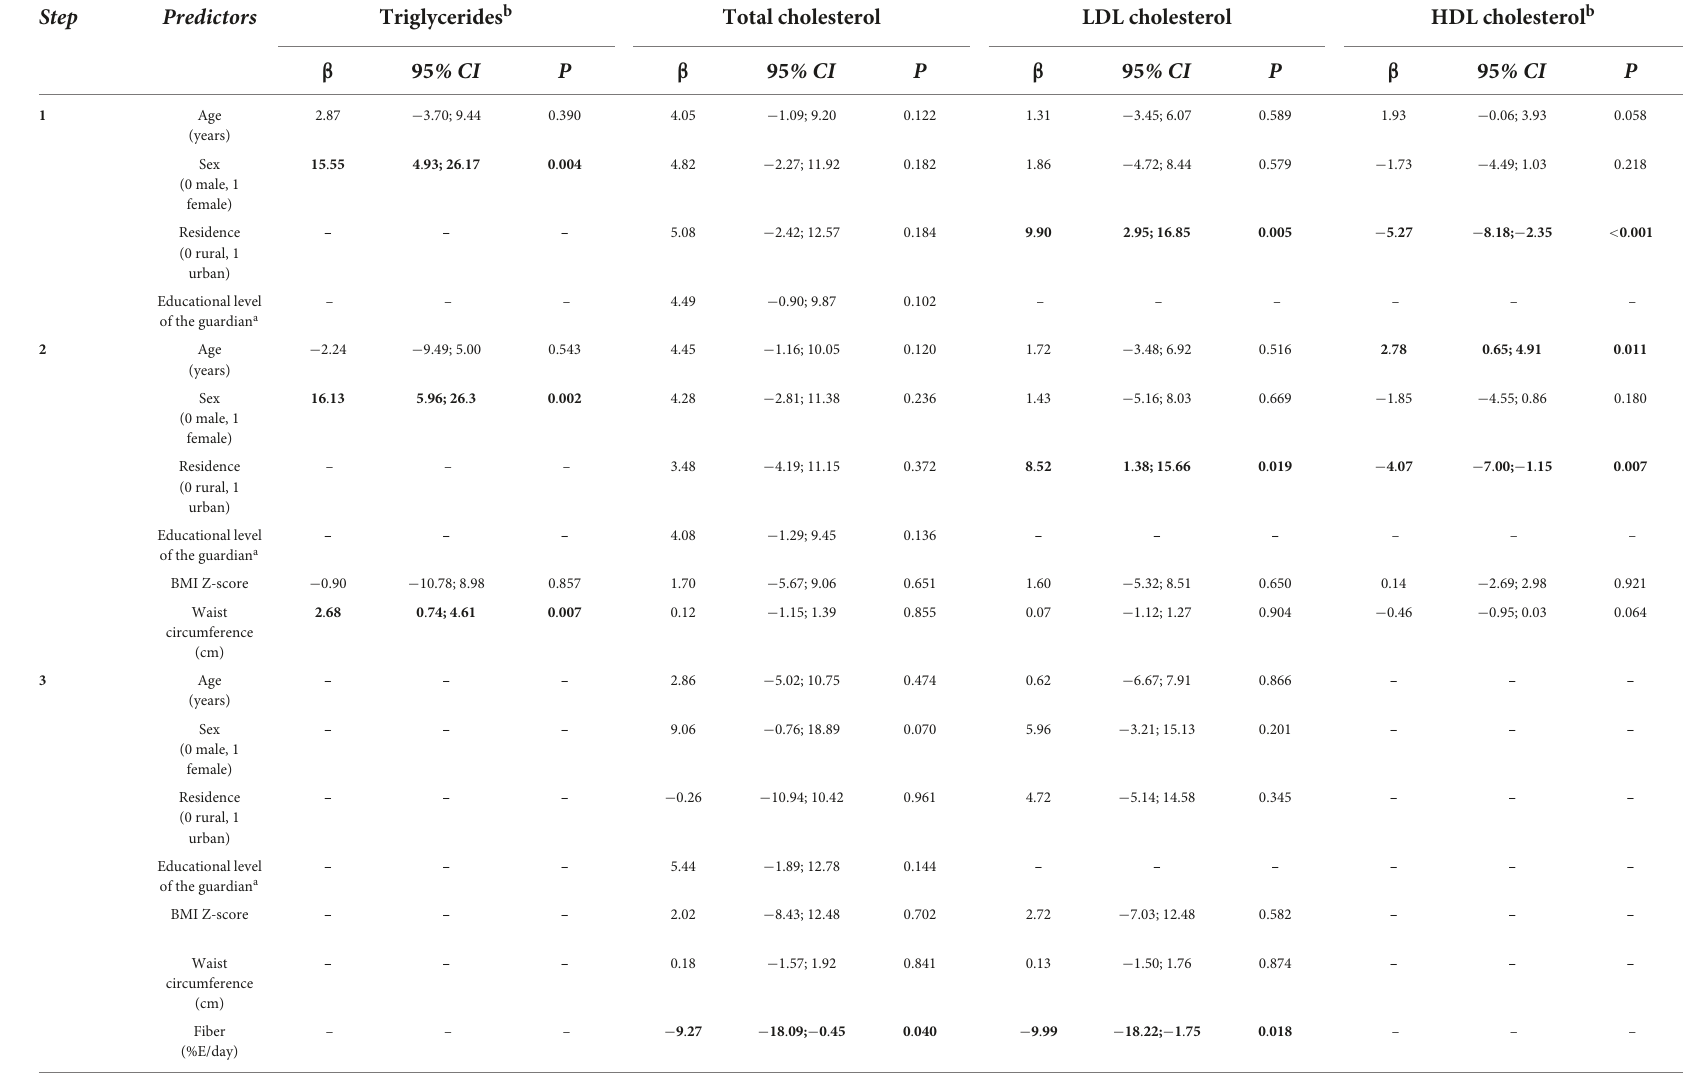
TABLE 4 Associations between blood lipids, hepatic enzymes and adipokines with sociodemographic, anthropometrics, and nutrient intake data*.